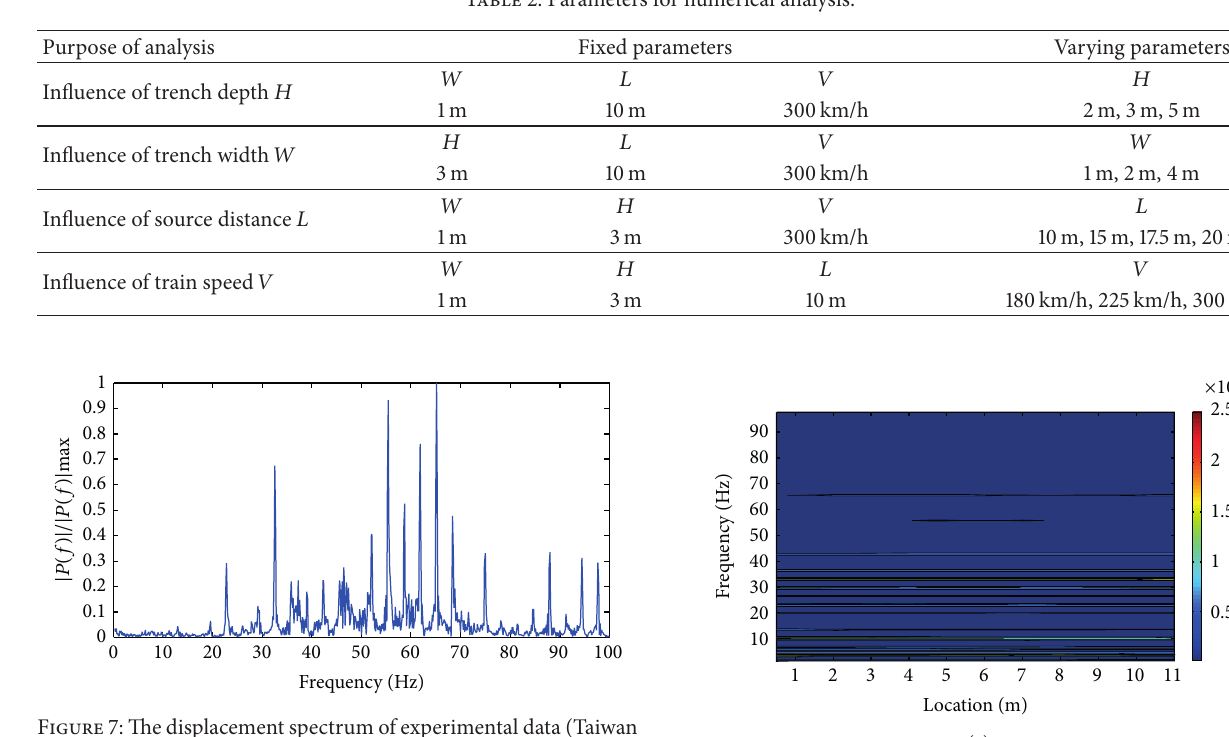
Table 2: Parameters for numerical analysis.